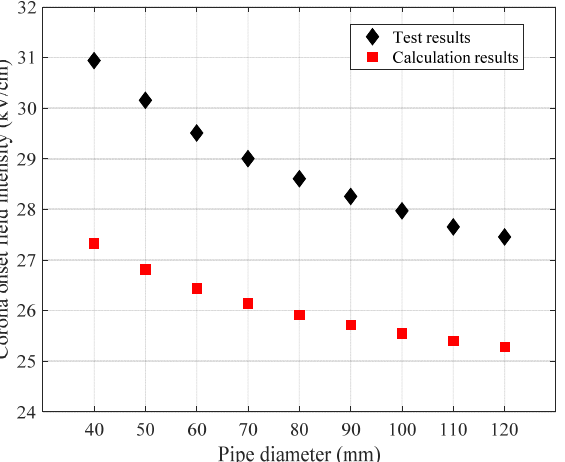
Figure 11. Test and calculation results of the COI of grading rings with different pipe diameters.